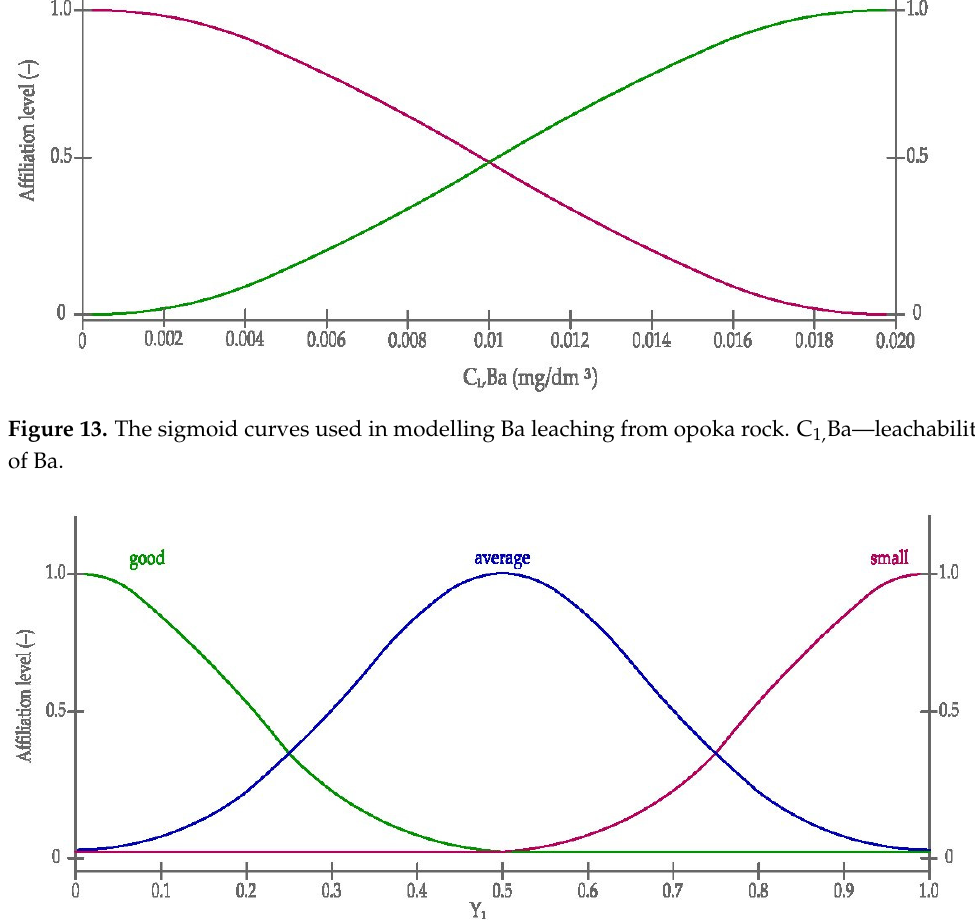
Figure 14. The sigmoid and Gauss curves used in modelling output quantity. Y 1 —diagnostic assessment of the value of the output variable.